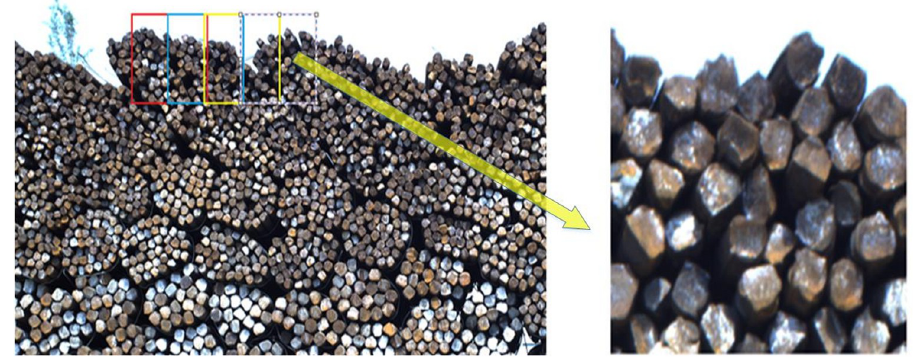
Fig 2. (Color online)Schema for splitting and rescaling. The left image is the original rebar image, and the right image is a slice from the original image that rescaled to 1024 × 1024 pixels.